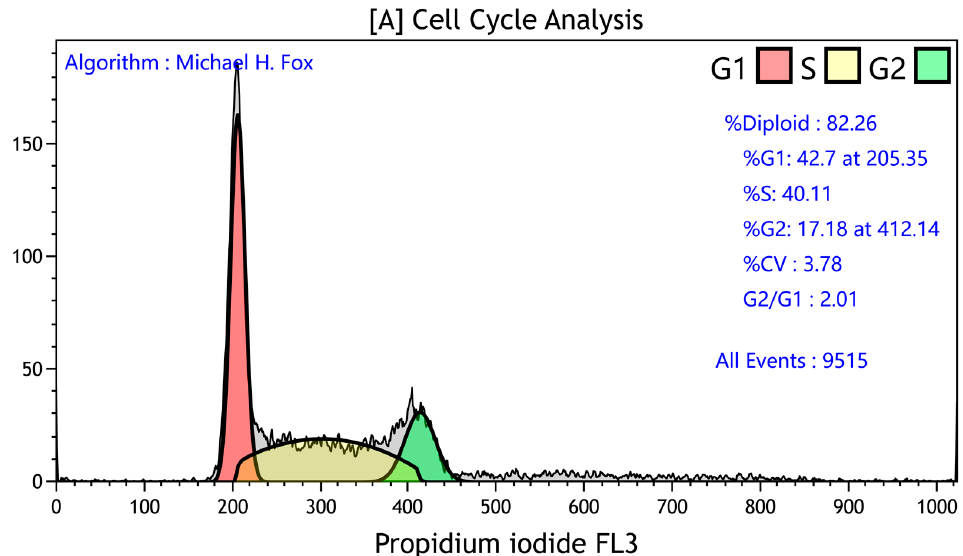
Figure 3. An example of cell cycle analysis using PI. The percentage of cells in distinct cell cycle phases calculated using Kaluza Analysis Software 2.2 (Beckman Coulter, Brea, CA, USA) based on the Michael H. Fox algorithm.